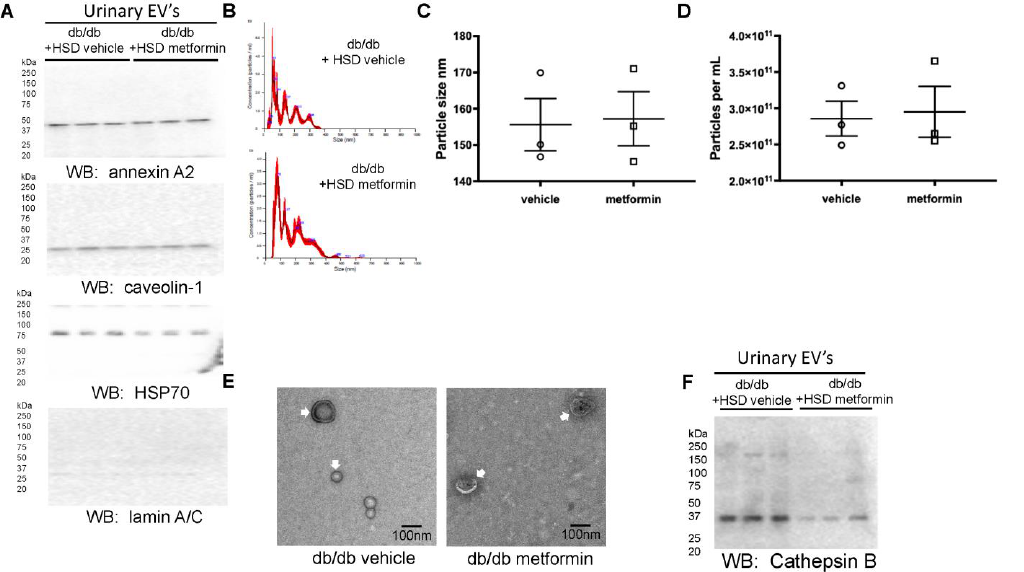
Figure 6. Characterization of urinary EVs from vehicle- or metformin-treated db/db mice on an HSD. ( A ) Western blot for the presence of the EV markers annexin A2, caveolin-1, HSP-70, and the absence of the non-EV protein lamin A/C. ( B ) Nanoparticle tracking analysis showing EV peak profiles from diabetic db/db mice maintained on an HSD and treated with vehicle or metformin. ( C ) Summary plot showing EV size in nanometers (nm) in each group. ( D ) Summary plot showing EV concentration in particles/mL in each group ( E ) Transmission electron microscope micrographs of pooled EVs from each group showing the absence of aggregated proteins and the presence of EVs less than 200 nm in diameter. ( F ) Western blot depicting the enrichment of cathepsin B in urinary EVs from each group. N = 3 EV preparations per group.